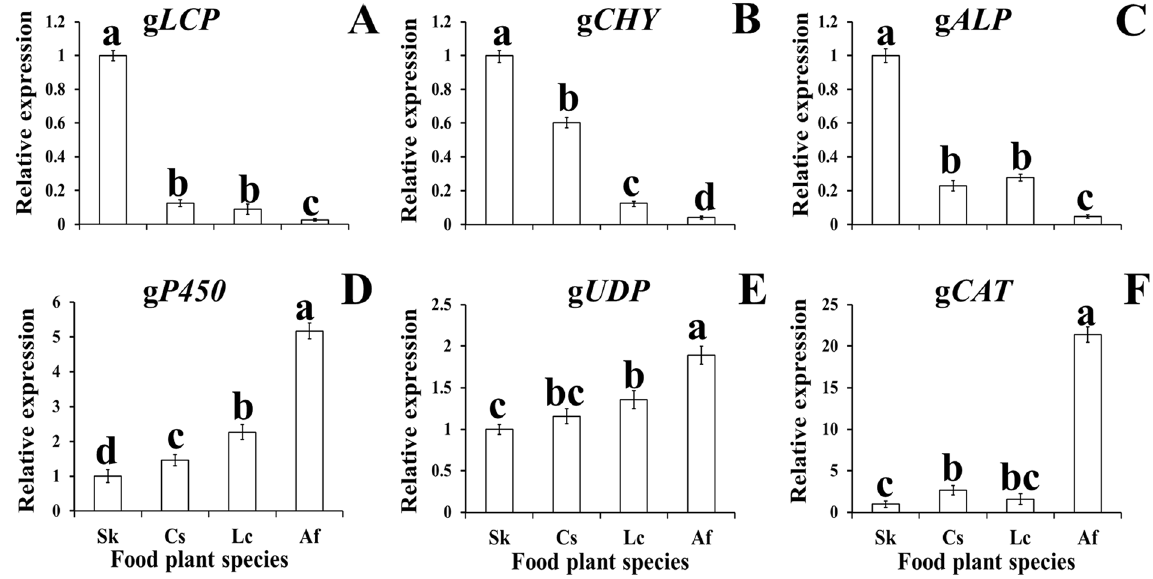
Figure 6. Relative expression ( ± SD) of six candidate genes for O. asiaticus feeding on S. krylovii (Sk), L. chinensis (Lc), C. squarrosa (Cs), and A. frigida (Af). Different lower case letters indicate a significant difference among the four treatments at P = 0.05. Key: g LCP : Cuticle protein 6; g CHY : TPA_exp: chymotrypsin 2; g ALP : alpha-glucosidase; g UDP : UDP-glucuronosyltransferase 2C1; g P450 : cytochrome P450 6K1; g CAT :